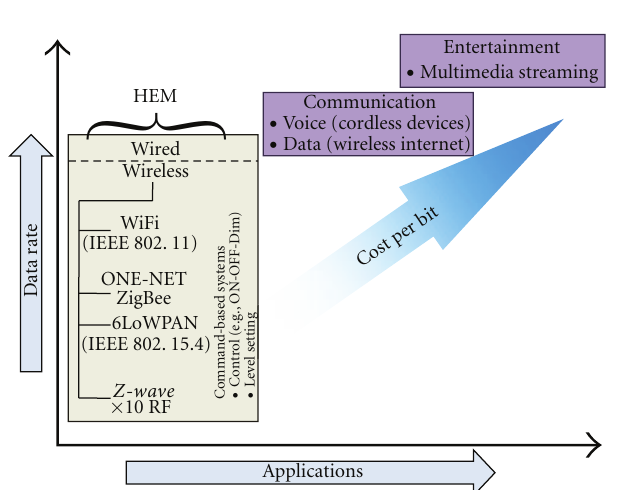
Figure 3: The cost and use of wired and wireless technologies for di ff erent home